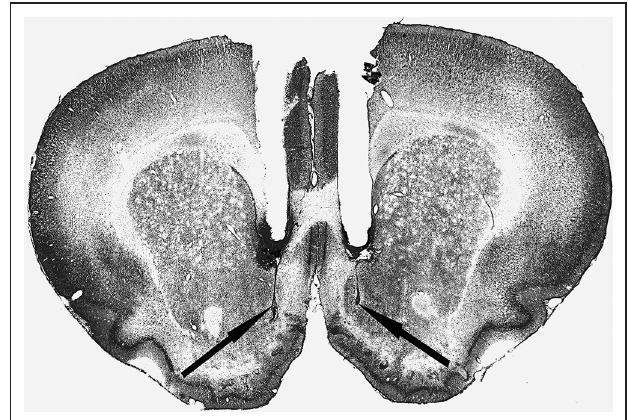
FIGURE 2 | Representative photomicrographof the coronal